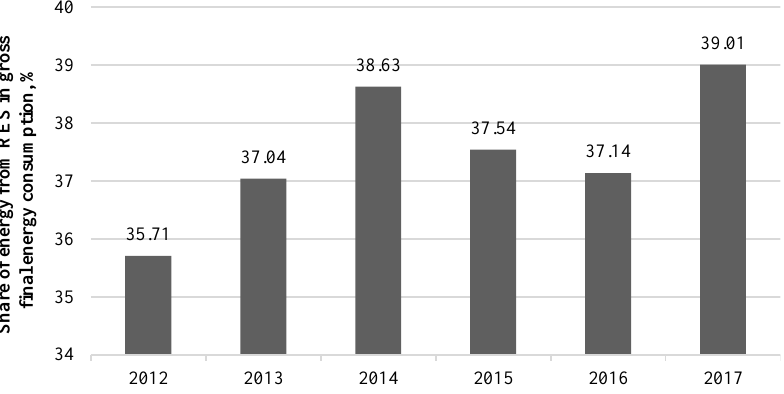
Fig. 1. Trends in the share of RES in Latvia from the years 2012–2017